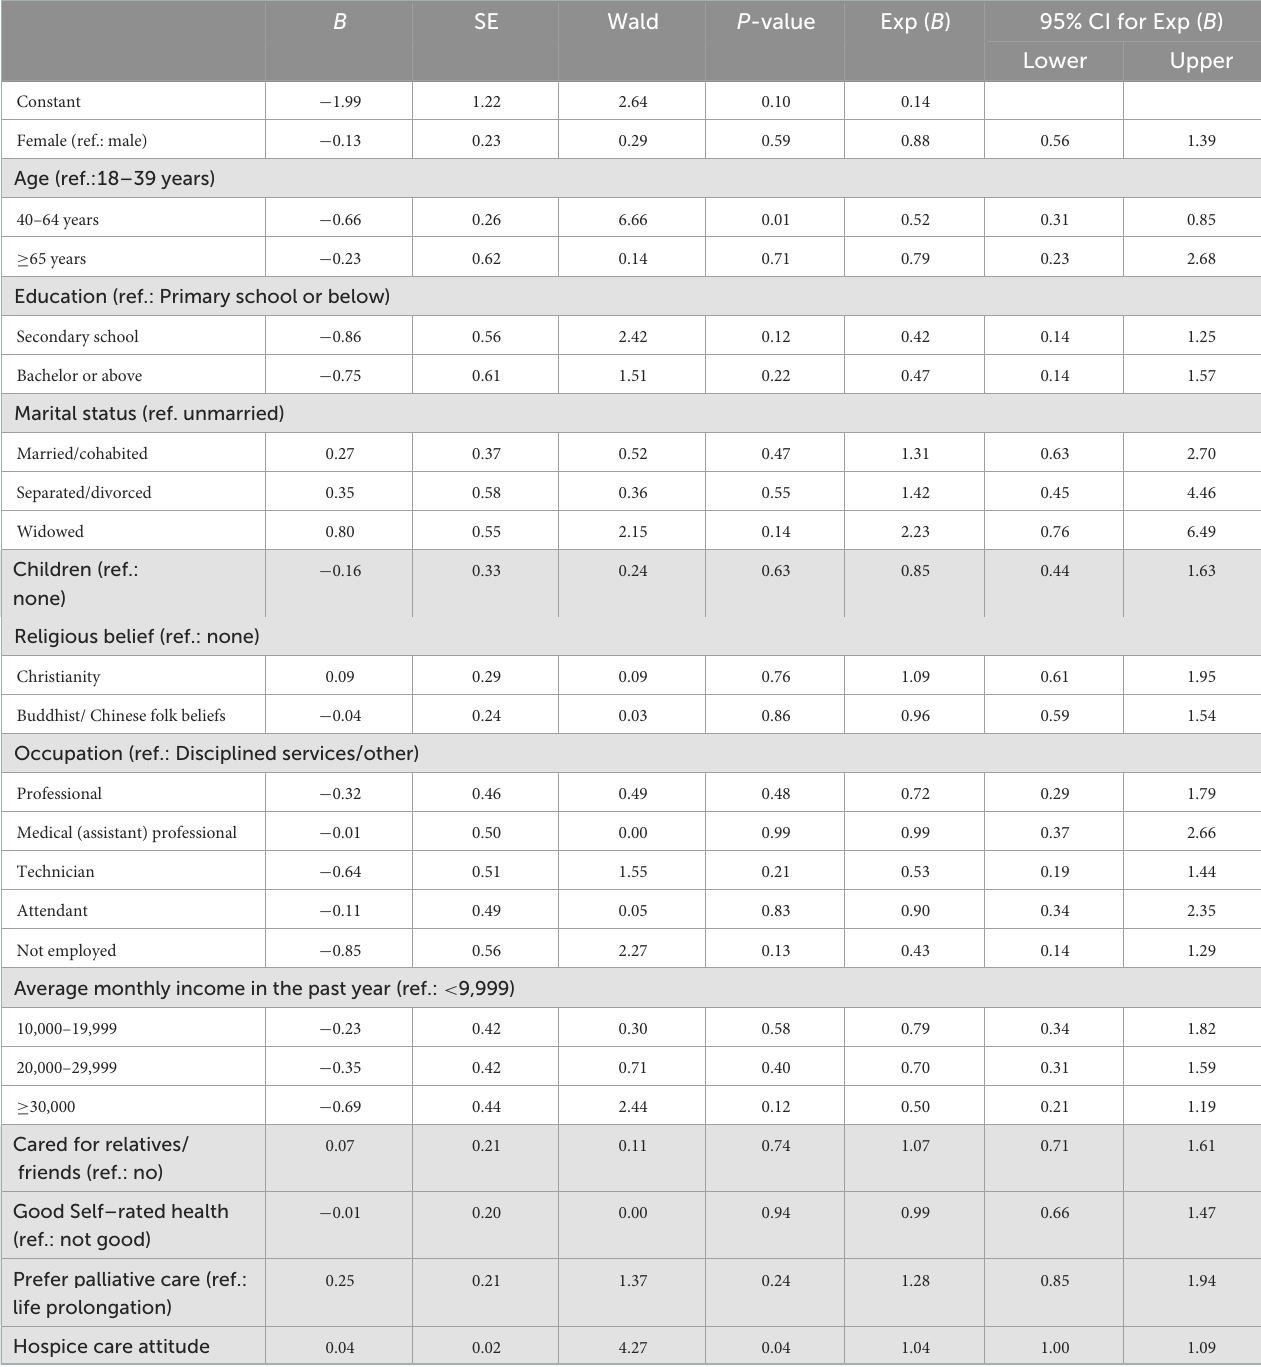
TABLE 6 Multiple logistic regression models of predictors of home as the preferred place of death ( n = 686). B SE Wald P -value Exp ( B ) 95% CI for Exp ( B )